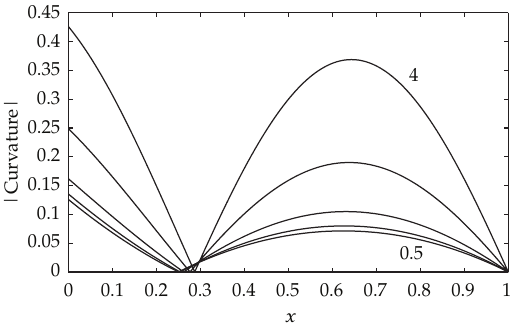
Figure 9: Graphs of the magnitude of the curvature for B (cid:5) 0 . 5 , 1 . 5 , 2 . 5 , 3 . 5 , 4.